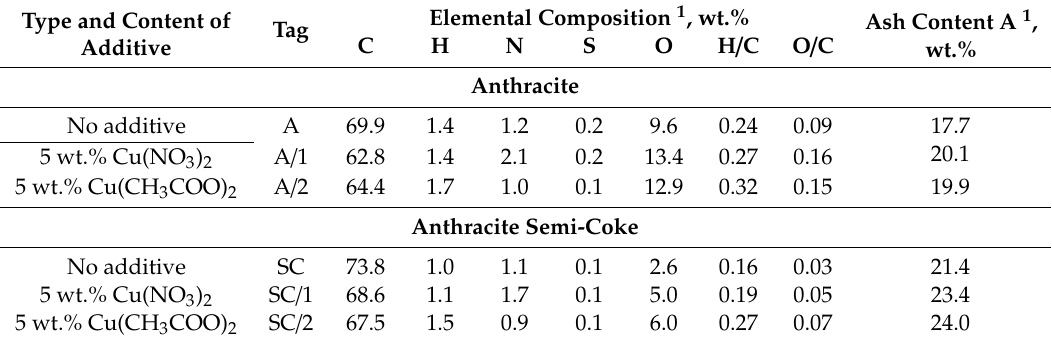
Table 2. List of the synthesized samples, their designations and chemical